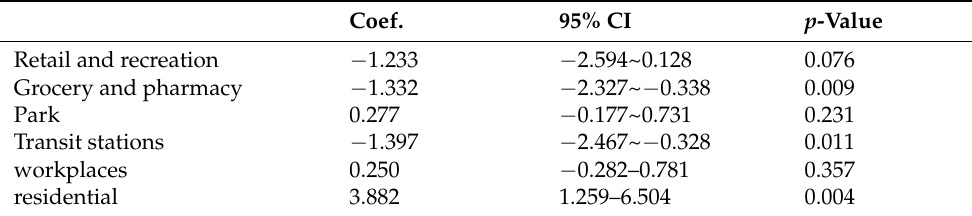
Table 2. Relationship between changes in the population flow of various locations and daily new confirmed cases per million people (7-day rolling